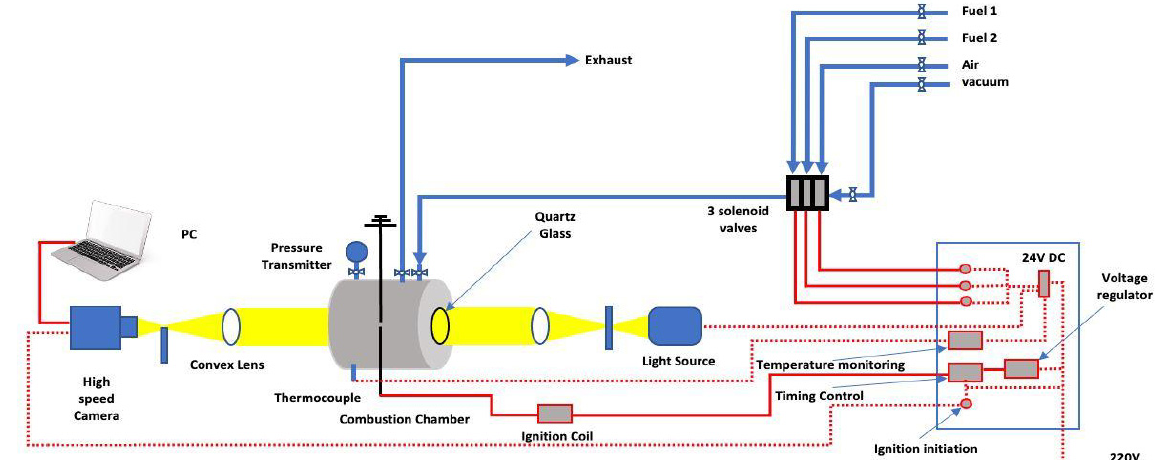
Figure 2. Schematic diagram of the experimental set